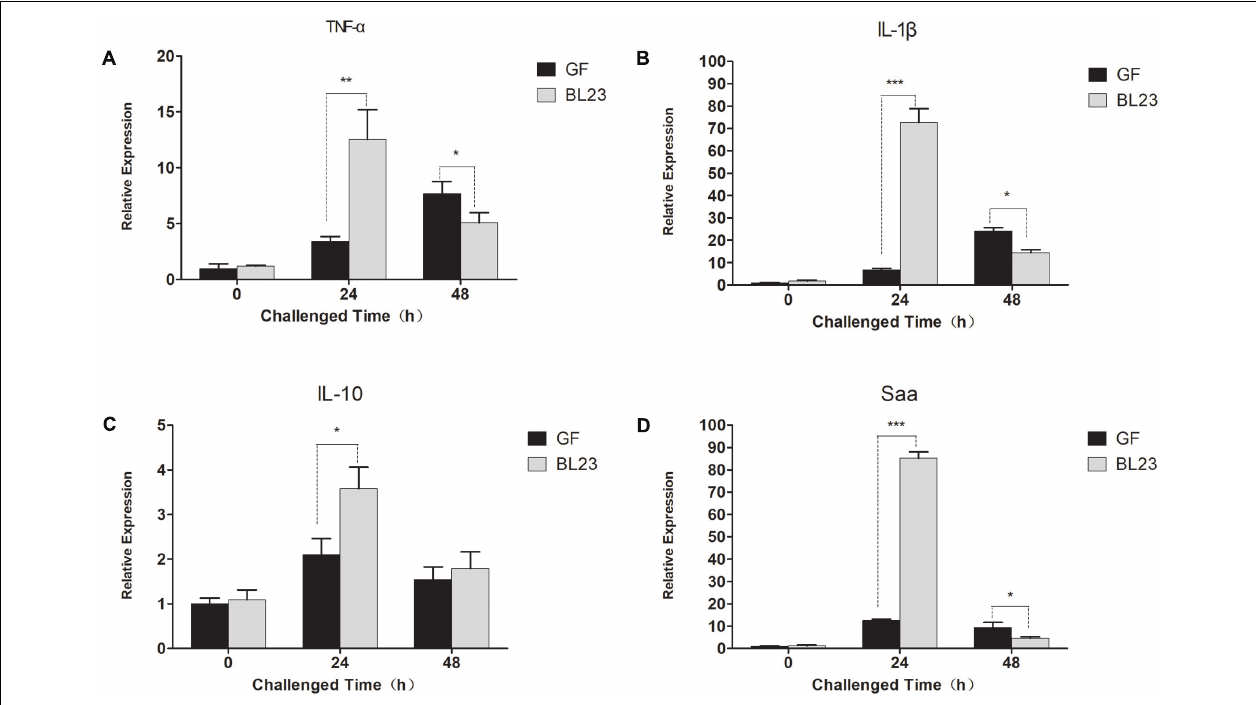
FIGURE 3 | Lactobacillus casei BL23 modulated immune response against A. veronii infection in zebrafish. The mRNA levels of TNF- α (A) , IL-1 β (B) , IL-10 (C) , and Saa (D) from GF and L. casei BL23(10 6 CFU/mL) treated zebrafish at certain time points after infected with A. veronii . The results are given as mean ± SEM ( n = 3). Asterisks indicate significant difference compared with control ( ∗ P < 0.05, ∗∗ P < 0.01, ∗∗∗ P <